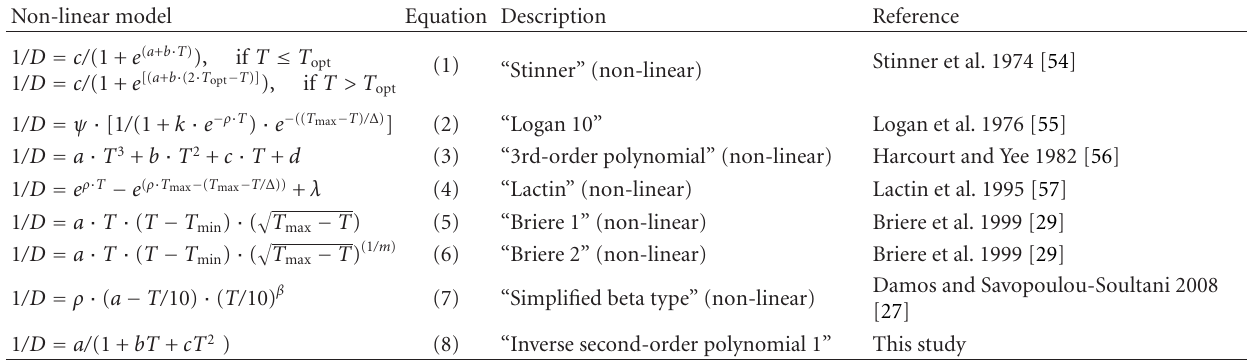
Table 1: Some representative regression models that have been created for the description of temperature-dependent development of insects and related